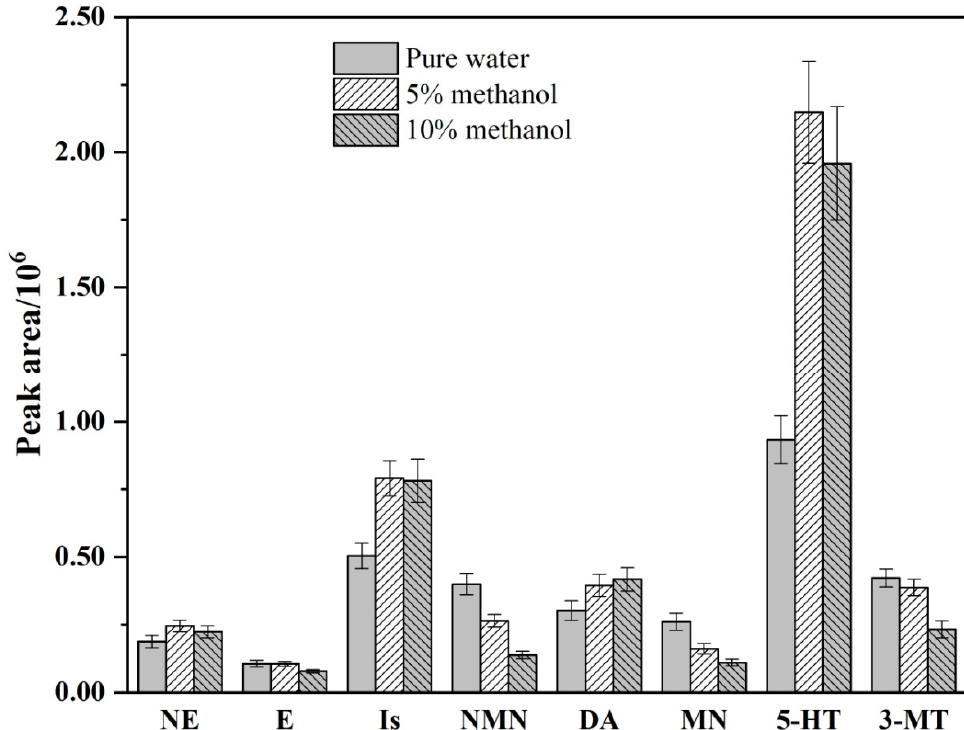
Figure 3. Comparison of peak area of the biogenic monoamines at different carrier mobile phase.